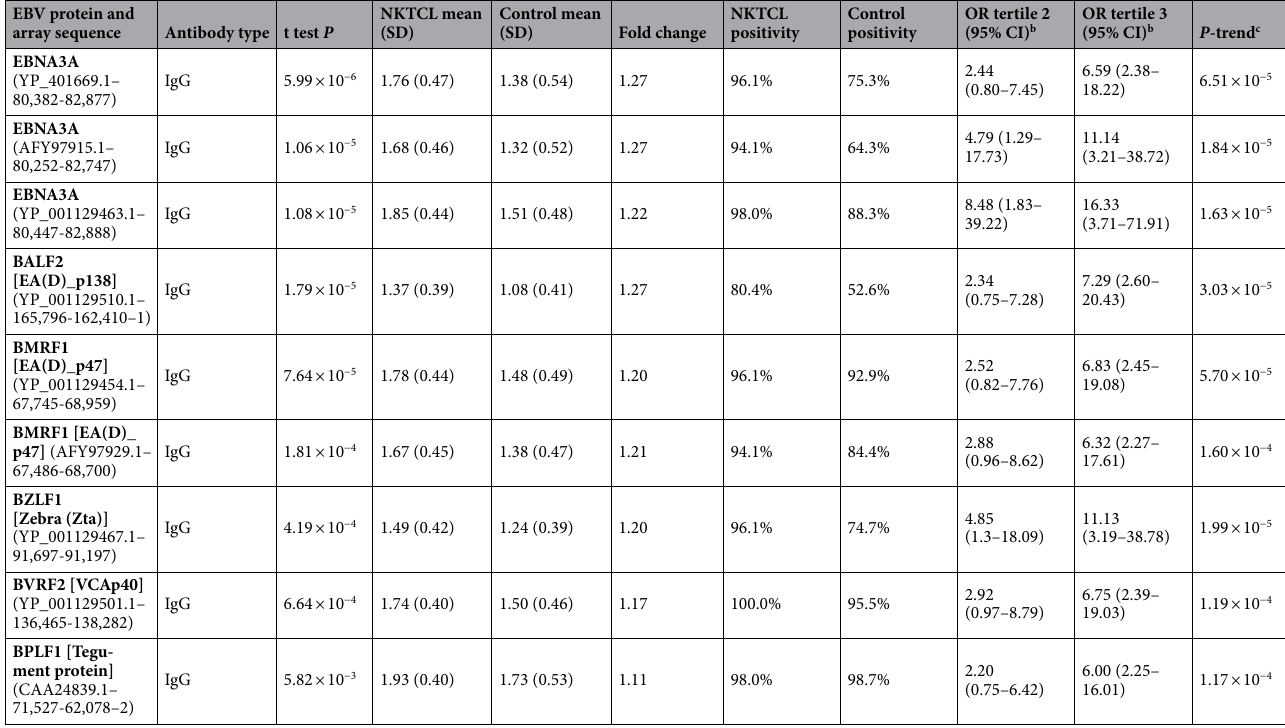
Table 2. OR and 95% CI for the association between anti-EBV antibody level and NK-T cell lymphoma (NKTCL) in Hong Kong and Taiwan a . Bold text is used to highlight the canonical EBV protein name. The remaining (non-bolded) text describes the sequence details of the array probe. CI, confidence interval. SD, standard deviation. a The table is ordered by t test P value (lowest to highest). b The odds of being a NKTCL